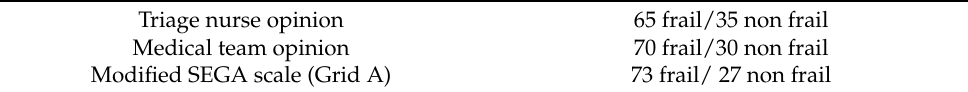
Table 3. Evaluation of frailty.